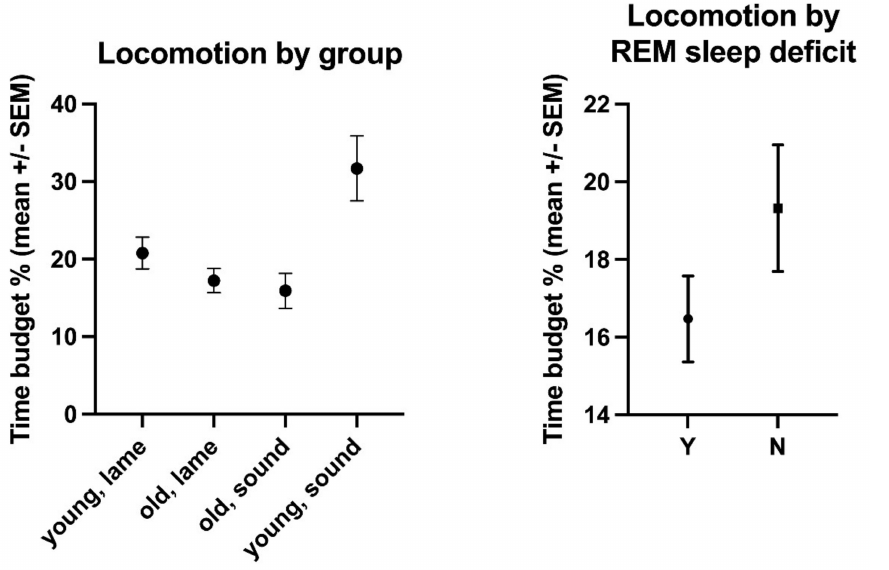
Figure 6. Comparative locomotion time budgets (mean % of 24 h +/ − SEM) of the horses enrolled in this study by age/lameness group and by the diagnosis of REM deficit (Yes (Y) and No